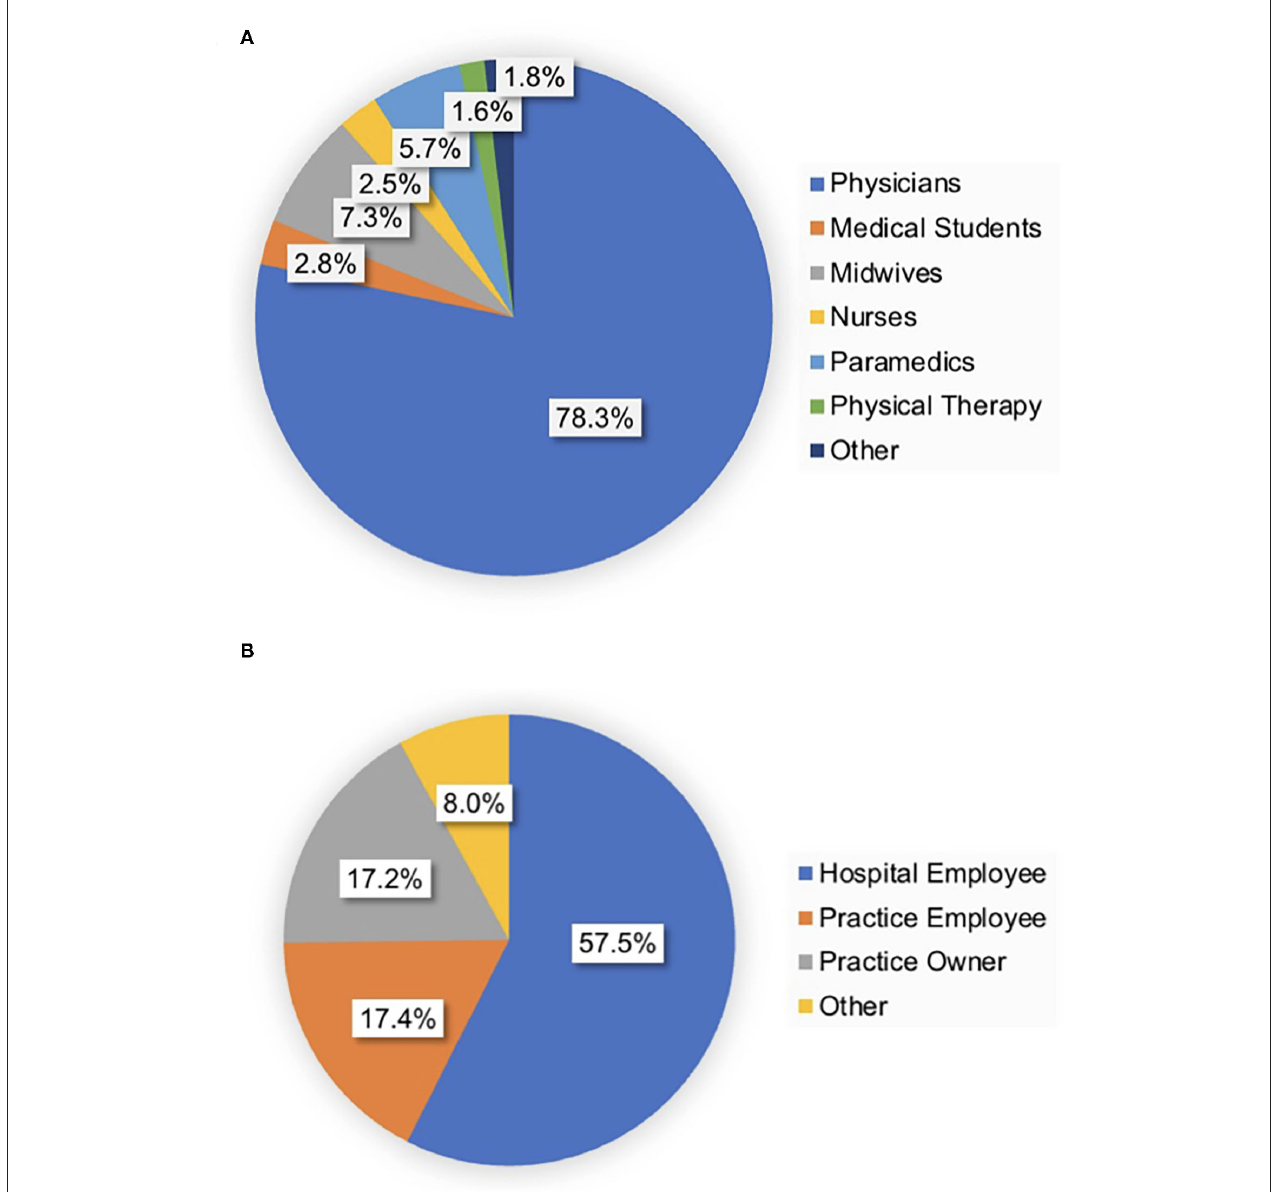
FIGURE 1 | Healthcare professions of participants and occupation of physicians. (A) The majority of responders were physicians (78.3%) followed by midwives and paramedics. (B) Most physicians were hospital employees.